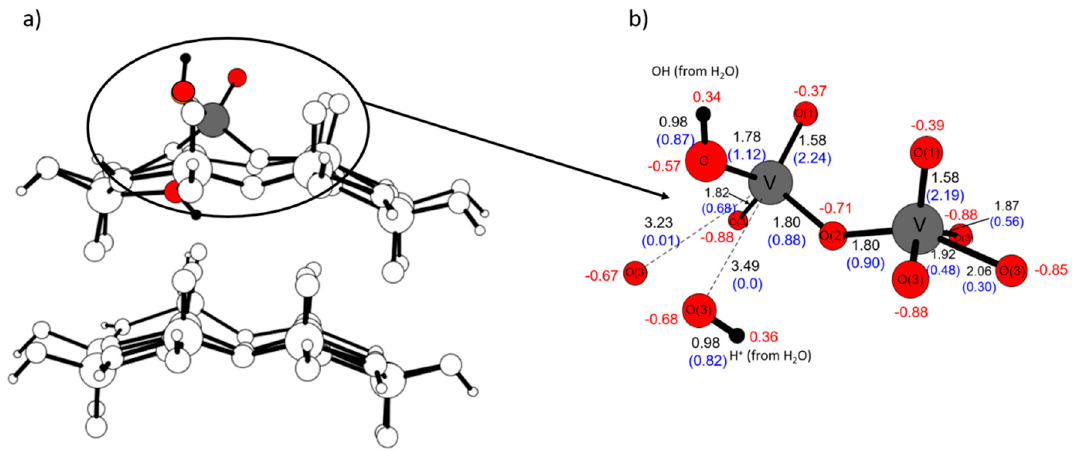
Figure 13. ( a ) V 20 O 62 H 22 (H 2 O) cluster representing results of the dissociative water adsorption at V=O and O(3) on the (010) V 2 O 5 surface—side view; ( b ) parameters characterizing V(=O)(–OH) group and their neighbors (black—bond lengths in Å; blue, in parentheses—bond order indices; red—Mulliken charges).